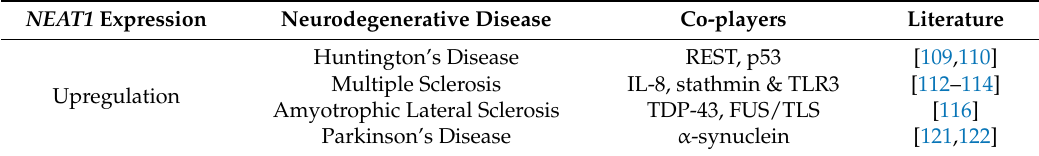
Table 2. NEAT1 expression levels in several neurodegenerative diseases and predicted